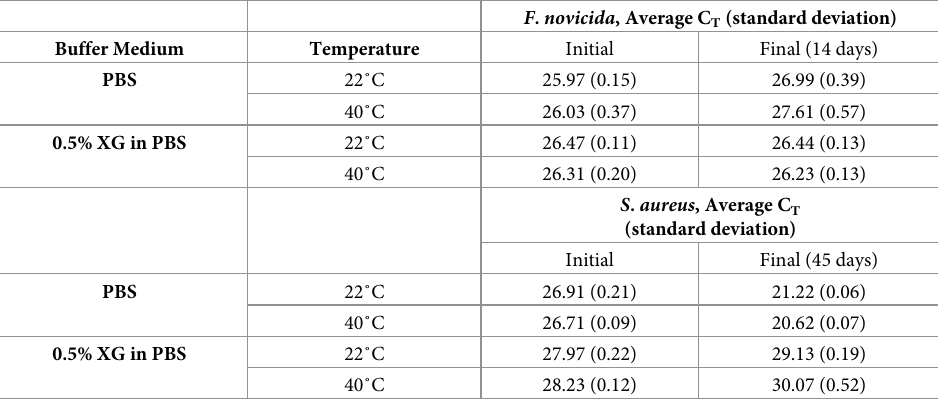
Table 4. Nucleic acid stability as assessed by real-time